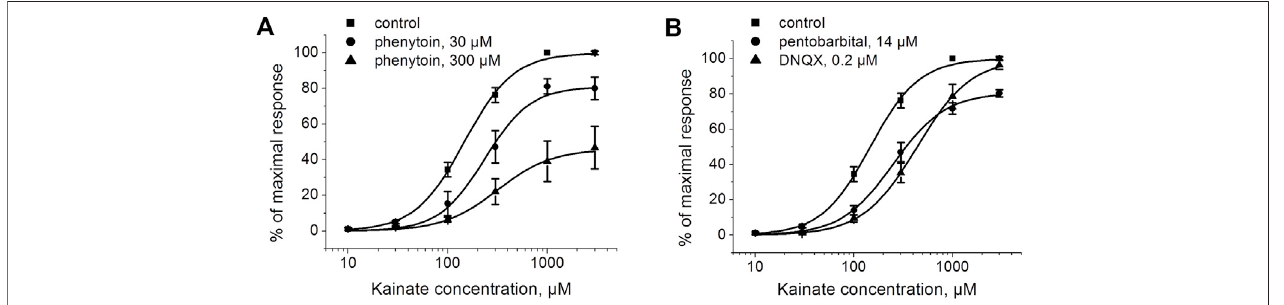
FIGURE4| Theactionofphenytoinisnotcompetitive. (A) Activationcurveforkainateincontrolandinthepresenceof30and300 μ Mphenytoin.Phenytoininboth concentrations reduced the maximal response to kainate, which suggests that inhibition by phenytoin is not competitive. (B) Activation curve for kainate in the absence and presence of 14 μ M pentobarbital and 0.2 μ M DNQX. Pentobarbital demonstrated inhibition even at high kainate concentrations as well, while DNQX induced a parallel shift of the kainate activation curve, which is typical for competitive inhibitors.